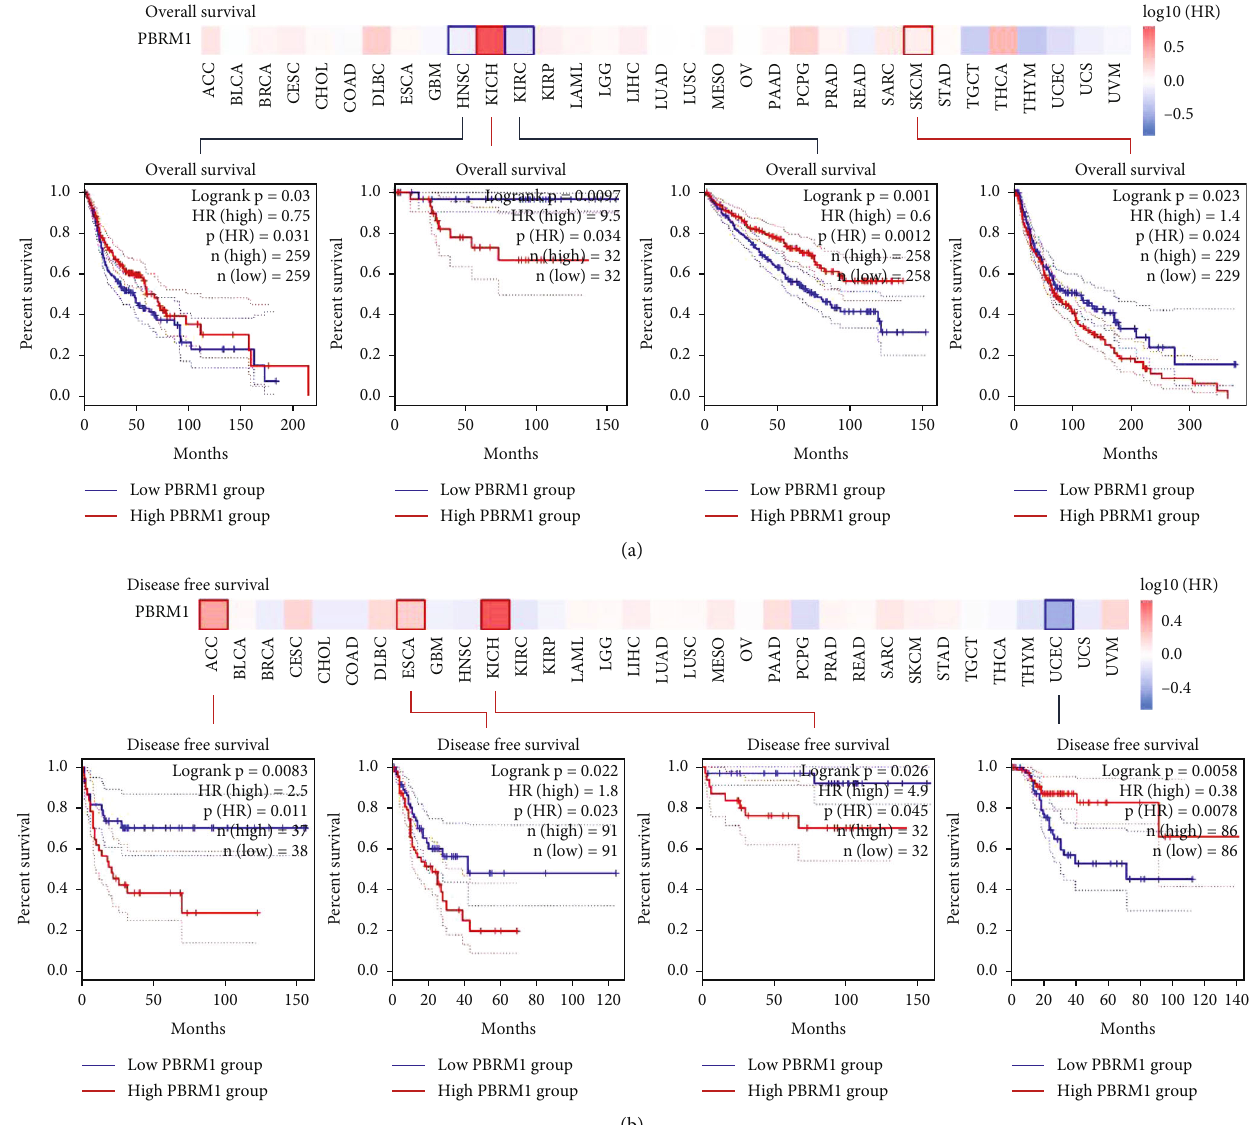
Figure 2: The relationship between PBRM1 expression level and survival rate in TCGA tumors. GEPIA2 was used to assess the association between PBRM1 gene expression and (a) overall survival and (b) disease-free survival in all TCGA tumors. Positive results for survival plots and Kaplan – Meier curves are